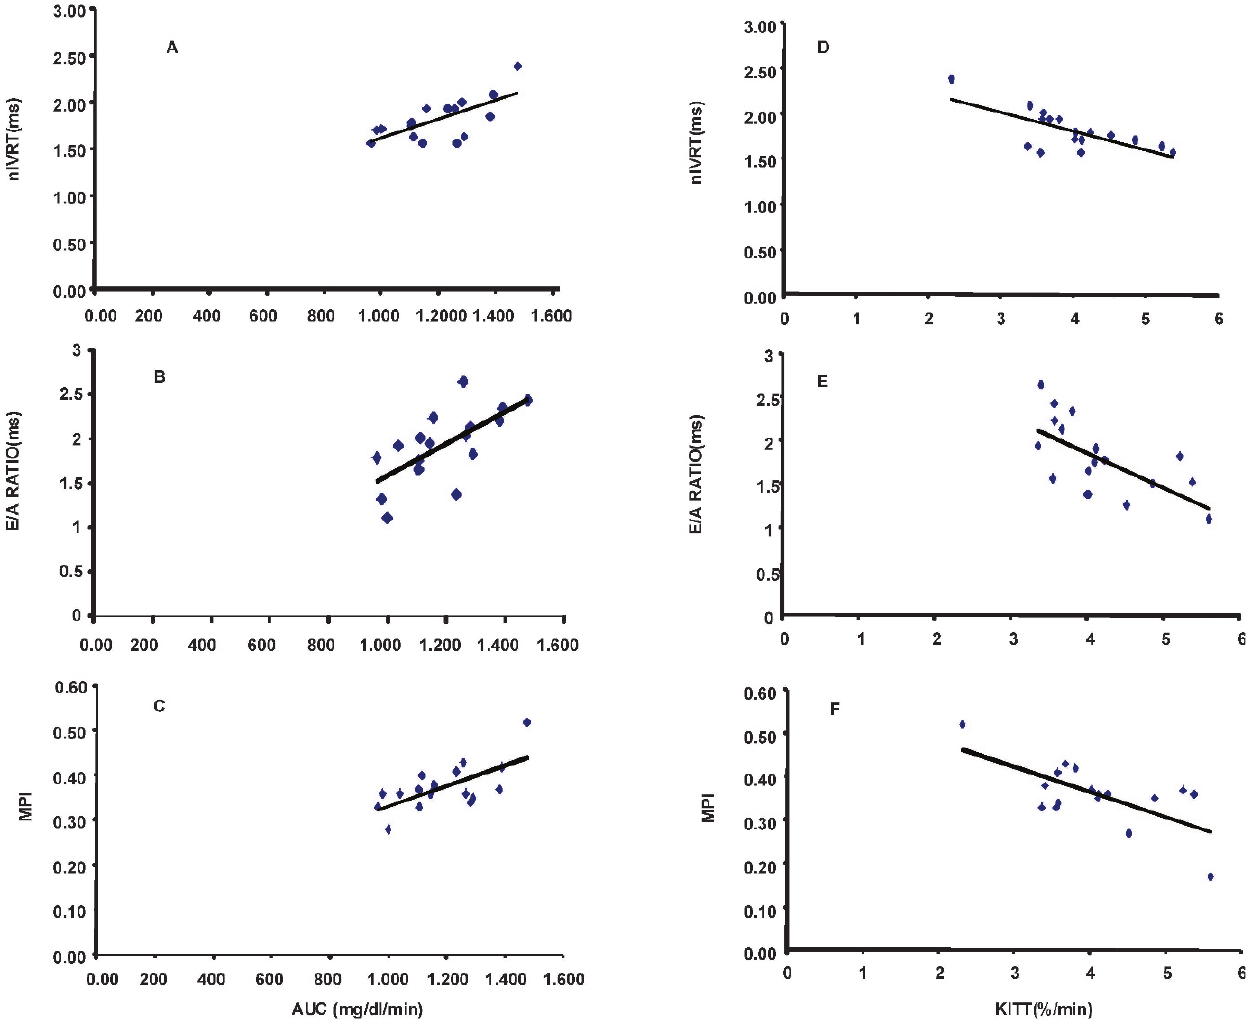
Figure 2 - Correlation analyses between insulin resistance index, diastolic index and global index. A: normalized isovolumetric relaxation time (nIVRT), B: ratio of maximal early diastolic peak velocity (E) and late peak velocity (A) of mitral flow (E/A ratio), C: myocardial performance index (MPI) vs . area under the curve of the rate constant for blood glucose disappearance (AUC) and D: nIVRT, E: E/A ratio and F: MPI vs . the rate constant for blood glucose disappearance (KITT), involving control, fructose-fed and trained fructose-